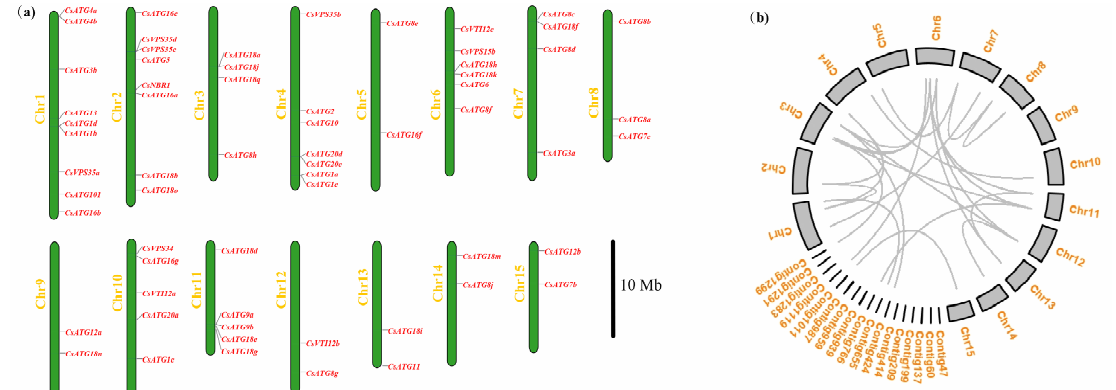
Figure 1. Chromosomal distribution and gene duplication of CsATG genes. ( a ) The distribution of 63 CsATG genes in 15 chromosomes. ( b ) The chromosomes and contigs containing the 80 CsATG genes, and the collinear pairs illustrated with one gray curve for one pair.